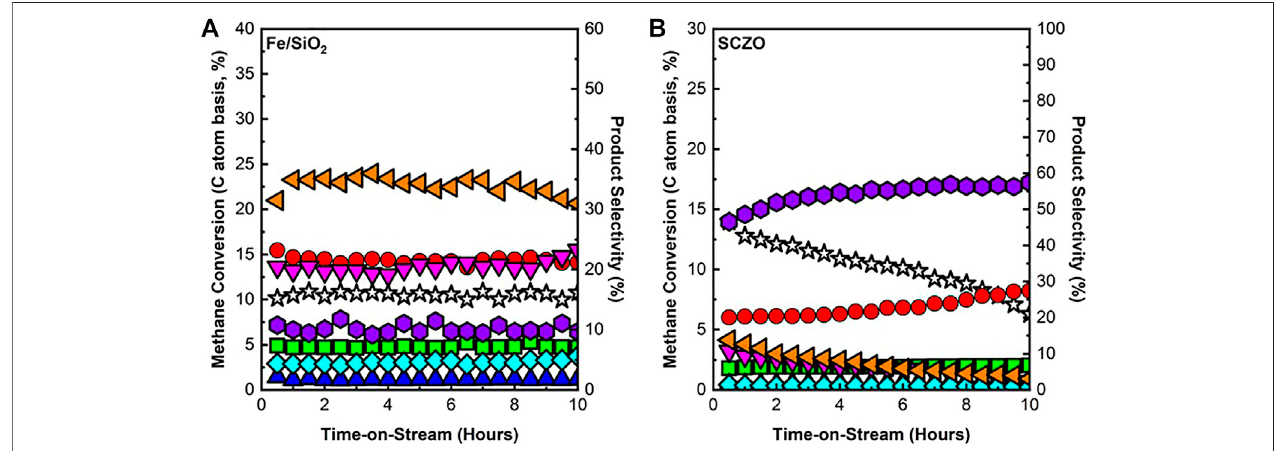
FIGURE 3 | CH 4 conversion and product selectivity of DNMC over Fe/SiO 2 catalyst (A) and SCZO perovskite oxide (B) materials (1273 K temperature, 101.325 kPa pressure, 3,200 mlg − 1 h − 1 space velocity, molar ratio of N 2 /CH 4 (cid:1) 1/9, N 2 used as internal standard) (symbol indicators: CH4 conversion, acetylene, ethylene, ethane, benzene, toluene, naphthalene, and